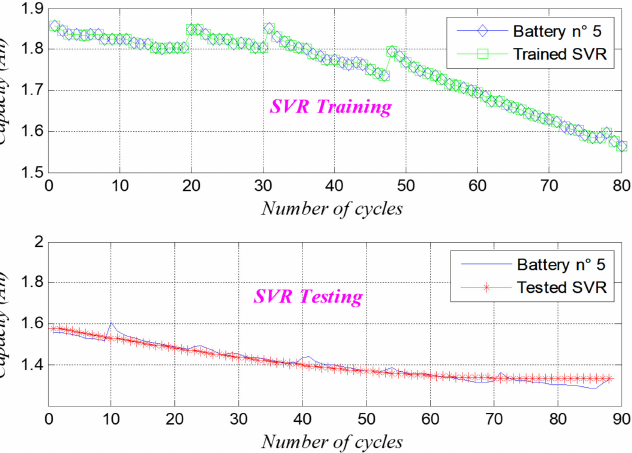
Figure 19. Capacity degradation and RUL prediction of Li-ion Battery #5 ( left ) based on linear regression, and ( right ) polynomial regression. Reproduced from [52], SAGE.